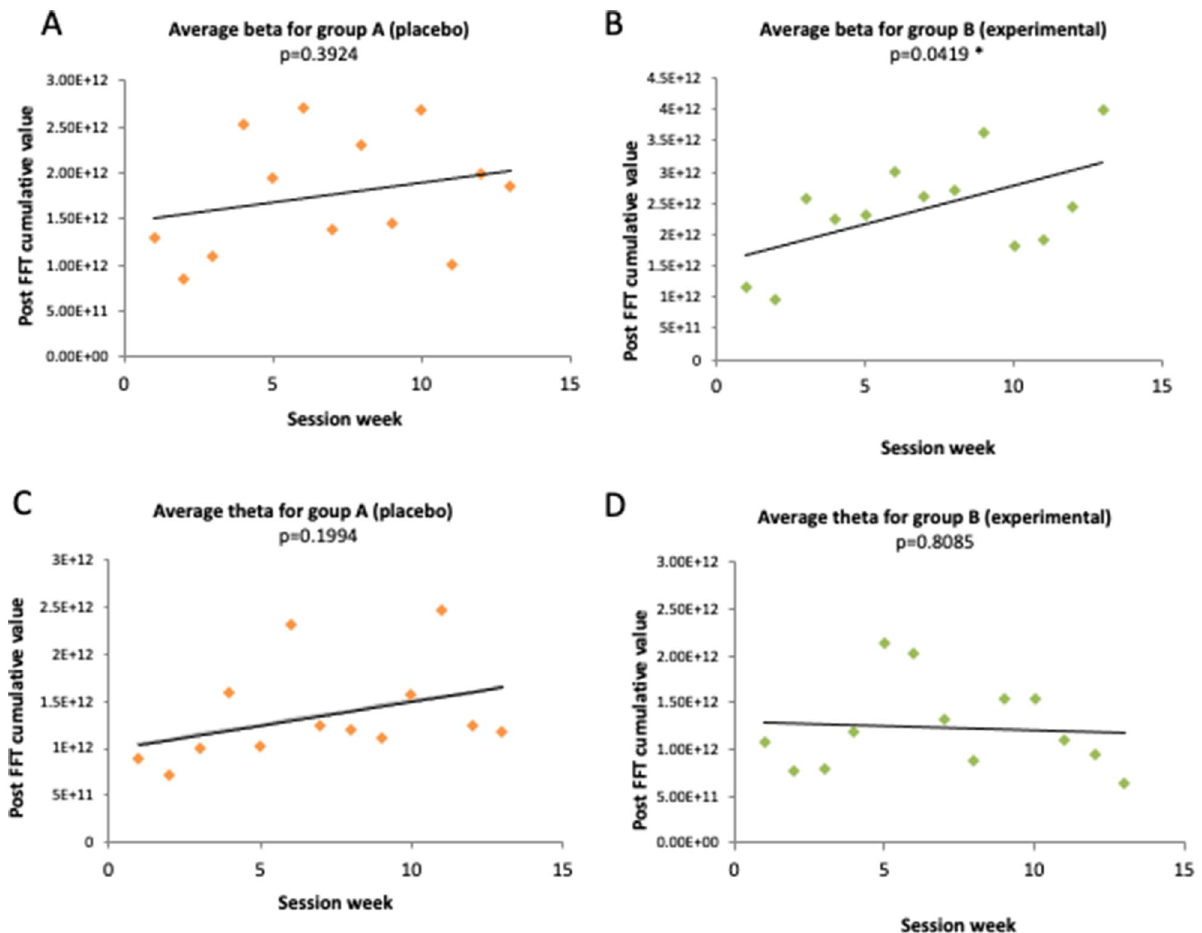
Figure 3. Cumulative average EEG values for placebo group A and experimental group B. EEG frequencies from 21 FSCT (experimental) subjects and 19 placebo FSCT (pFSCT) subjects were collected over a time interval of 13 consecutive weeks. The plots show the average cumulative beta frequencies (which reflect focusing ability and are linked to frontal lobes activity) ( A and B , upper panels) and theta frequencies (which are reflective of distractibility) ( C and D , lower panels) from these subjects. Linear regressions were calculated to evaluate the significance of the trends (* p <